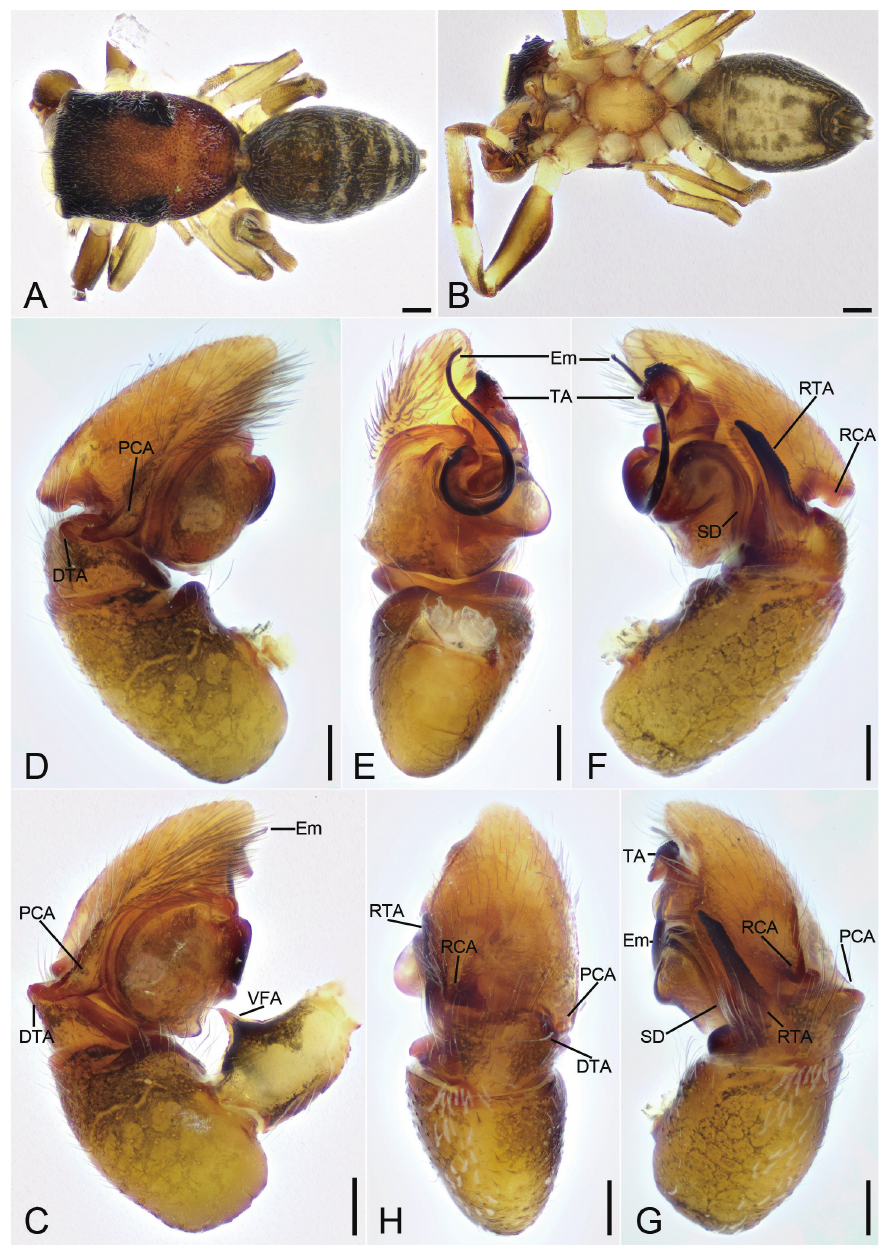
Figure 6. Synagelides serratus sp. nov., holotype male A habitus, dorsal view B same, ventral view C palp, detail of ventral femoral apophysis, prolateral view D same, prolateral view E same, ventral view F same, retrolateral view G same, retrolateral view, slightly dorsal H same, dorsal view. Abbreviations: DTA – dorso-prolateral tibial apophysis, Em – embolus, PCA – postero-prolateral cymbial apophysis, RCA – postero-retrolateral cymbial apophysis, RTA – retrolateral tibial apophysis, SD – sperm duct, SS – scale- like serrations, TA – terminal apophysis, VFA – ventral femoral apophysis. Scale bars: 0.2 mm ( A, B ); 0.1 mm ( C ); 0.05 mm ( D–H